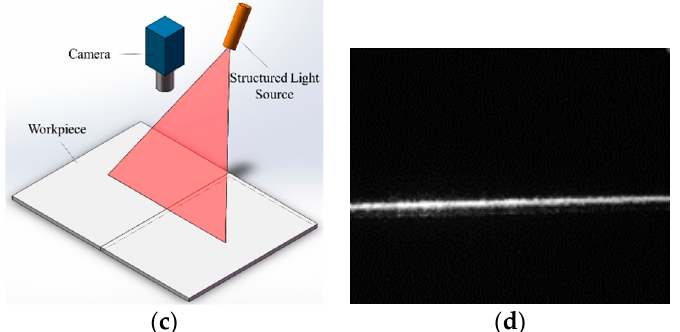
Figure 2. Structured light detection method applied to narrow butt detection. ( a ) Structured light is projected onto the groove with 1 mm width; ( b ) Captured image when the groove width is 1 mm; ( c ) Structured light is projected onto the groove with less than 0.2 mm width; ( d ) Captured image when the groove width is less than 0.2 mm.